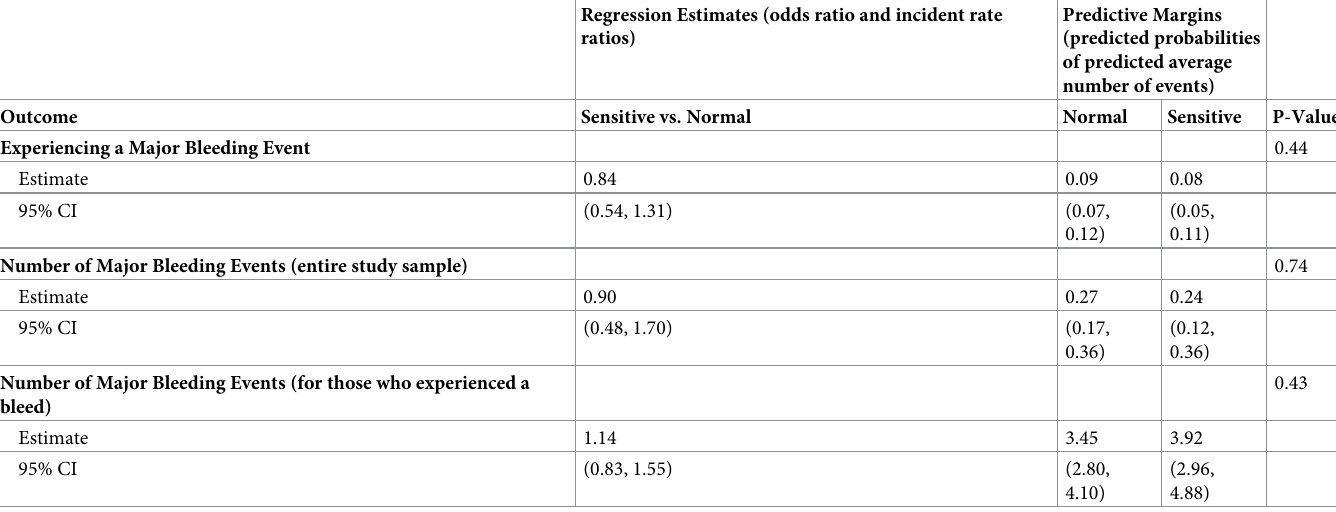
Table 4. Predicted probabilities of experiencing a major bleeding event and predicted average number of bleeding events across exposure groups for warfarin sensitivity a